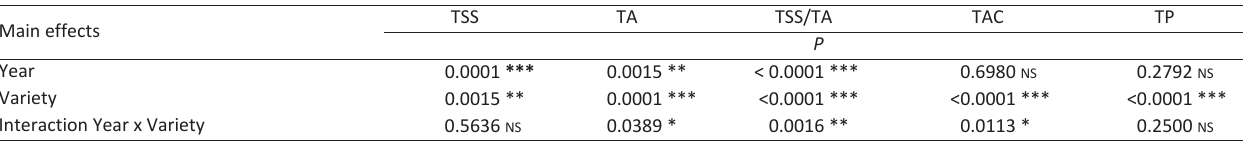
Table 3 - Two-way ANOVA results. Variables: TSS (°Brix), TA (meq malic ac. 100 g FW -1 ), TSS/TA, TAC (μmol TE g FW -1 ), and TP (mg GAE g FW -1 ) Main